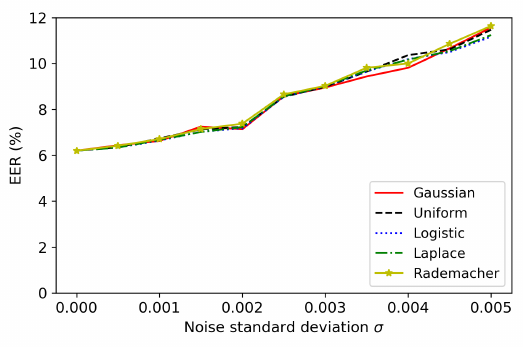
Figure 8. Performance of the noise-adding defense with different types of noise on the normal operations of GMM SV systems.